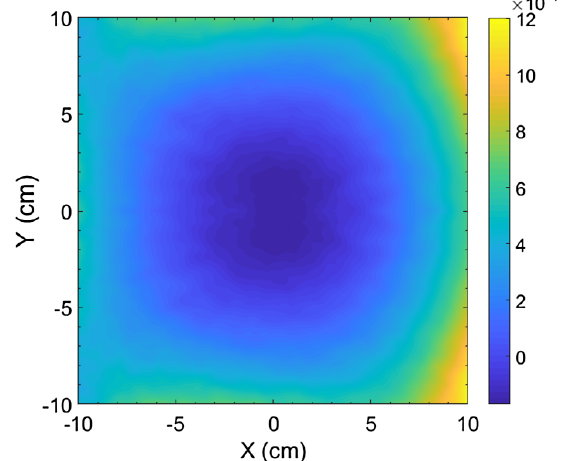
FIG. 7. Integrated field quality of the superconducting 90° combined-function magnet.